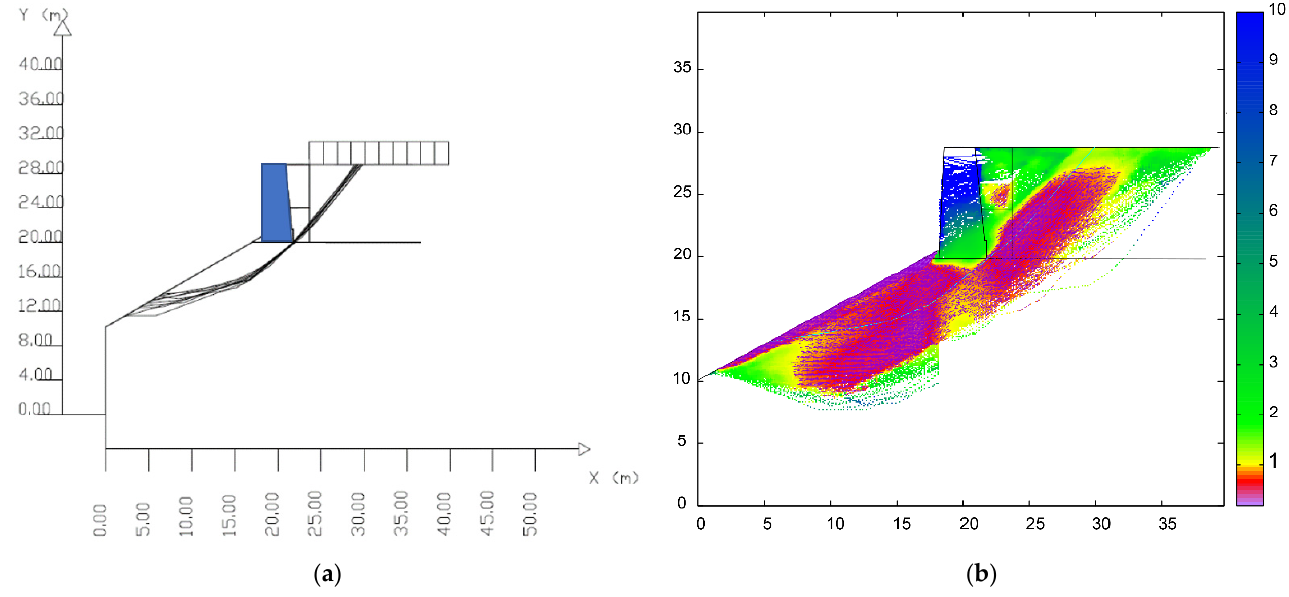
Figure 5. LEM analysis of sections 92–93 (Table 1) with the software SSAP2000 [73]. Surface failure ( a ) and contour of the safety factors ( b ).